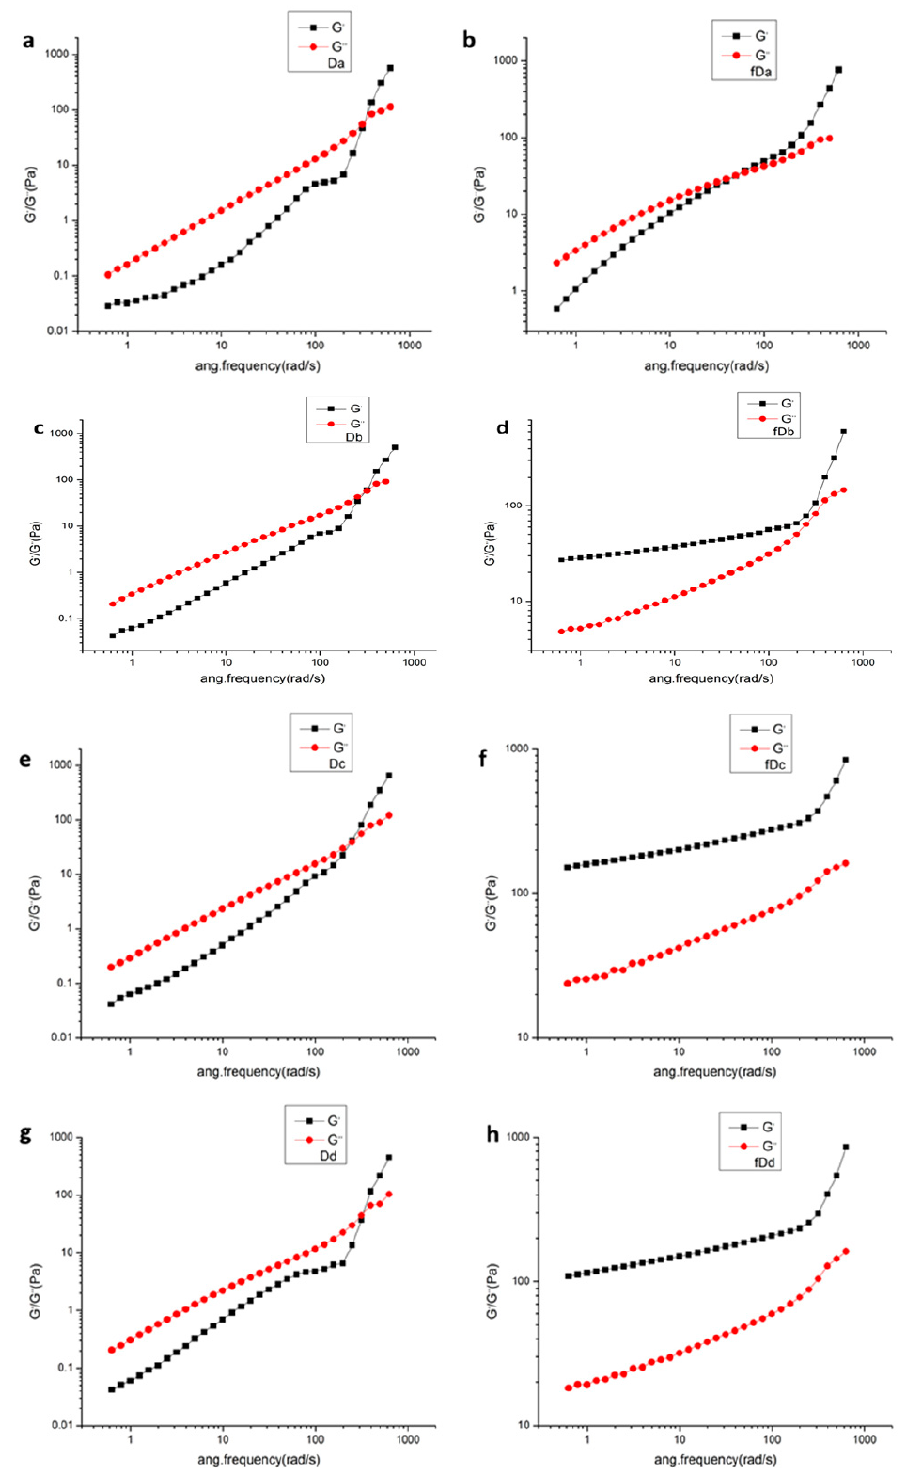
Figure 6. Frequency dependence of G ′ and G ′′ of KGM sols with different alkali addition before freezing ( a , c , e , g ) and after freezing ( b , d , f , g ) dealt.